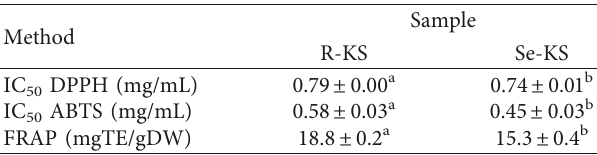
Table 2: Antioxidant capacities after passing gastrointestinal system simulation of regular Chinese kale seedling (R-KS) and Se- enriched Chinese kale seedling